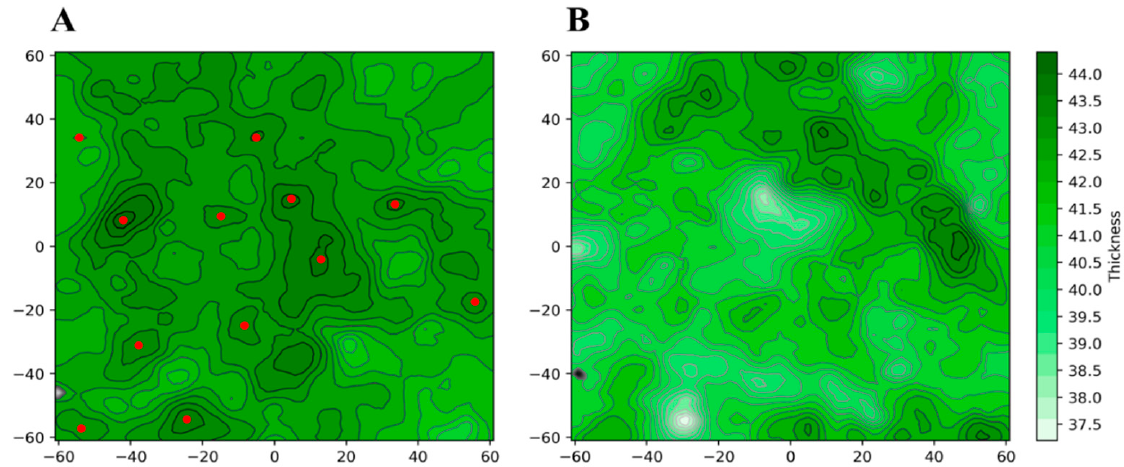
Figure 9. Membrane thickness as a function of the transverse plane of the membrane for the system simulated in the presence ( A ) and absence ( B ) of the PEL compounds.